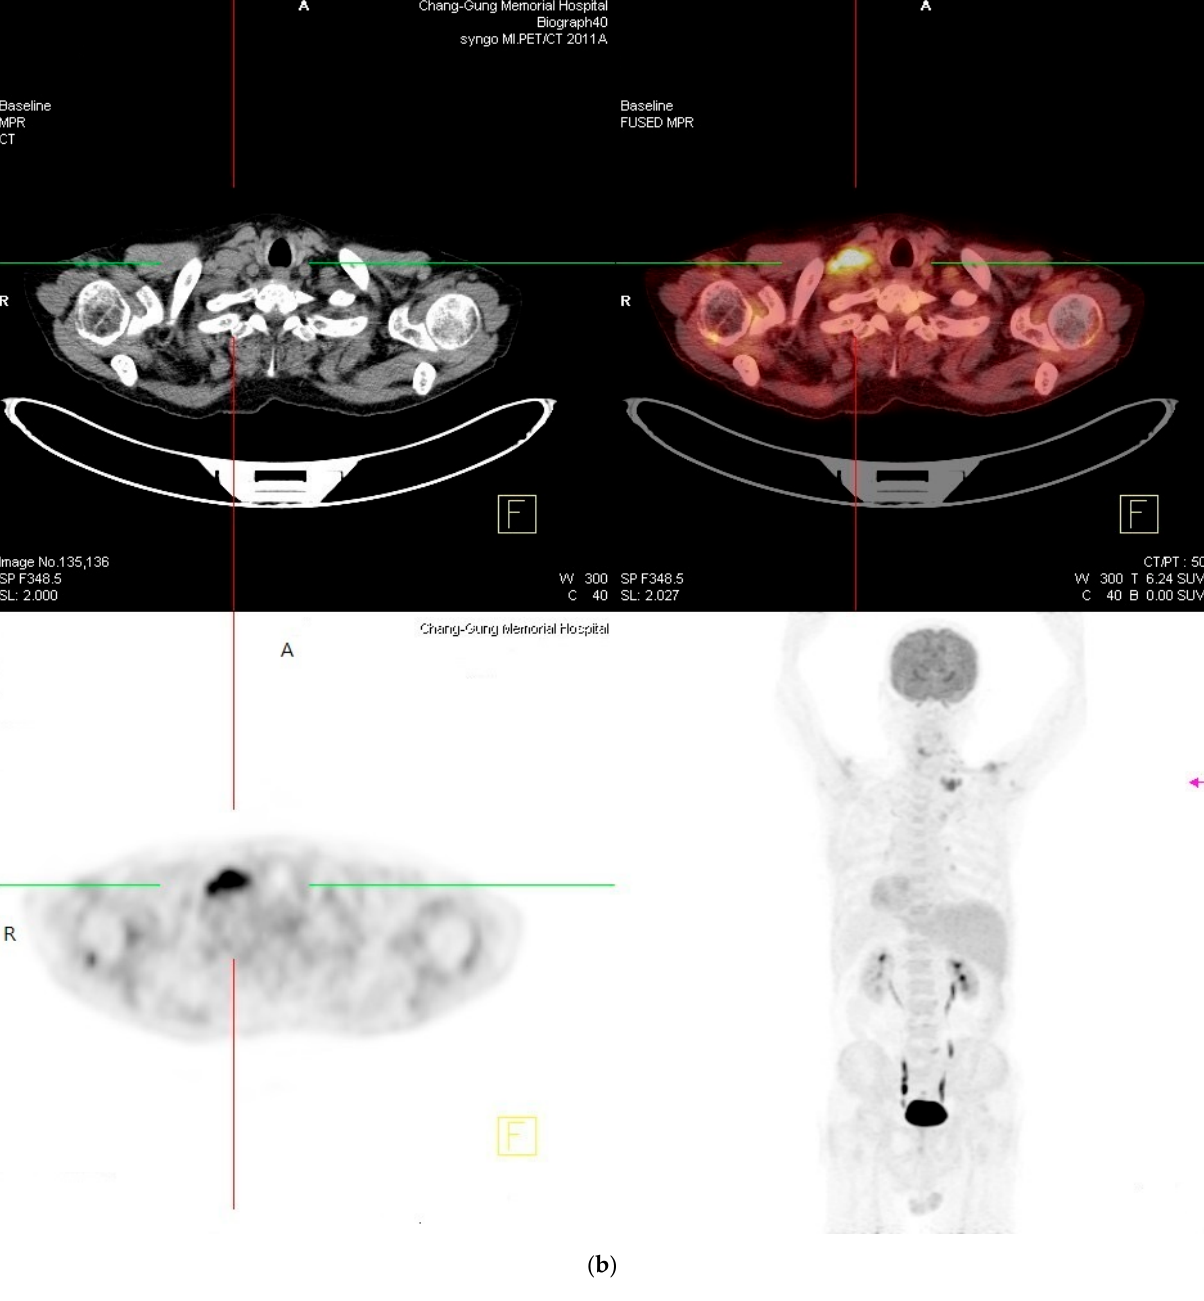
Figure 4. ( a , b ): Whole-body positron emission tomography-computed tomography revealed malig- nant involvement of the right cervical level III and V and supraclavicular lymph nodes. The uptake of radiation was elevated to standardized uptake value (SUV) 9.19, 3.79, and 10.15, respectively, corresponding to a score of 4 (high probability of